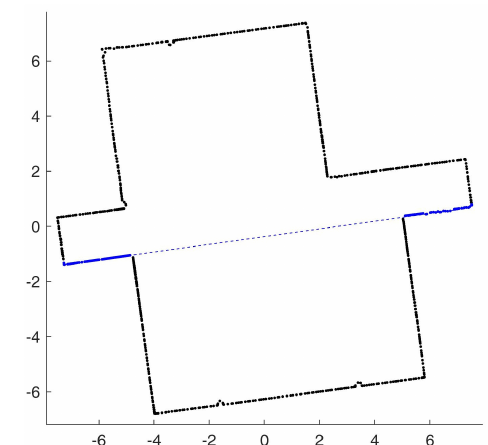
Figure 14: Example of an uncorrect identification of the